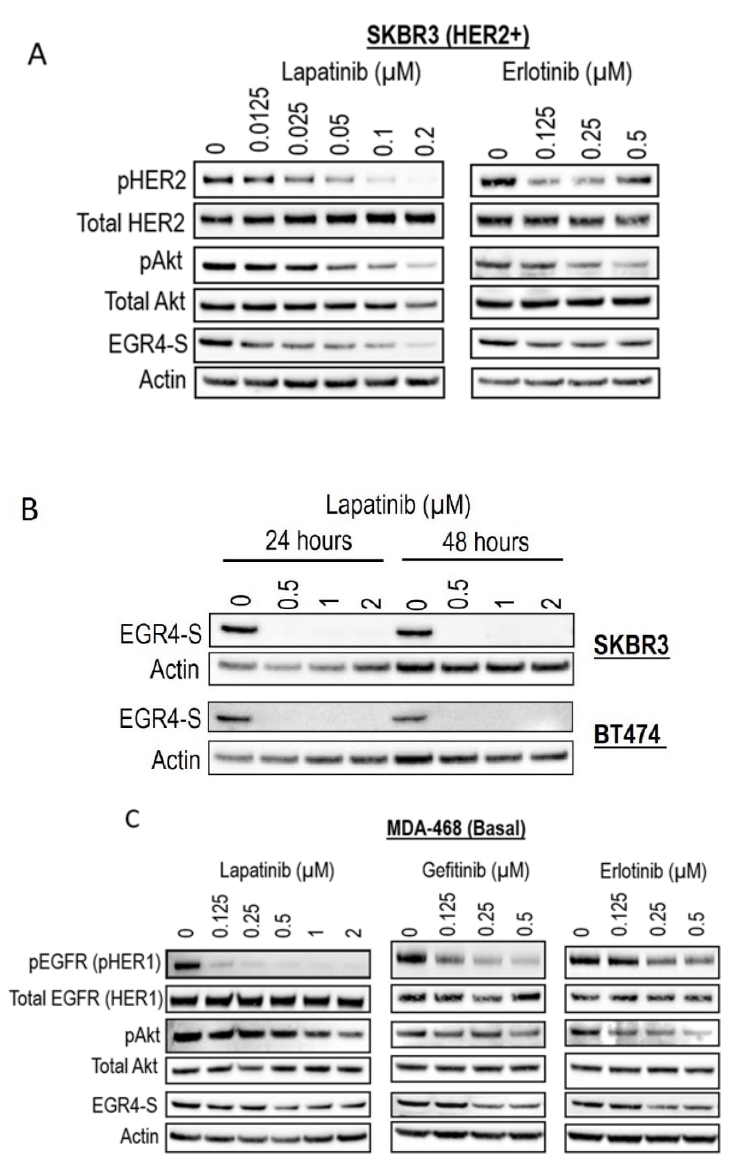
Figure 5. EGR4-S expression is regulated by HER- pathway targeted drug treatment. ( A ) Western blot analysis of HER2+ cell lysates treated for 24 h with increasing concentrations of TKI drugs (lapatinib, erlotinib) and ( B ) performed on indicated cell lysates treated over 24–48 h. ( C ) Western blot analysis of MDA-MB-468 breast cancer cell lysates treated with increasing concentrations of TKI drugs for 24 h (lapatinib, gefitinib, erlotinib).